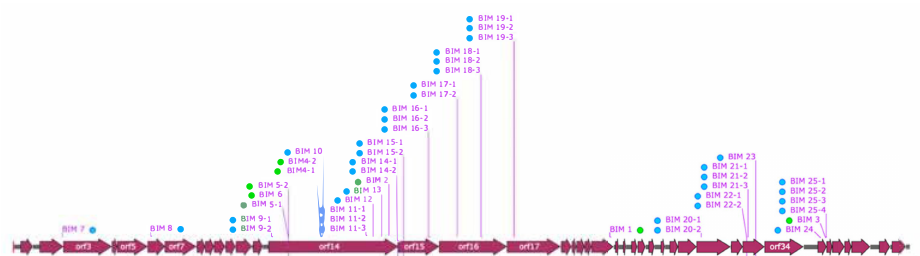
Figure 3. Ectopic spacer acquisition events observed for Uy01 bacteriophage insensitive mutants (BIMs). Spacers are aligned and their direction is shown from 5 (cid:48) to 3 (cid:48) , with respect to the leader sequence. The position of each spacer is relative to the leader end of the reference wild-type (WT) strain Uy01, with spacer 1 being the most distal. Each spacer is represented by a combination of colors based on their respective nucleotide sequence. The white spacers indicate that various spacers were acquired at these positions. The letter C followed by a number indicates a BIM cluster.